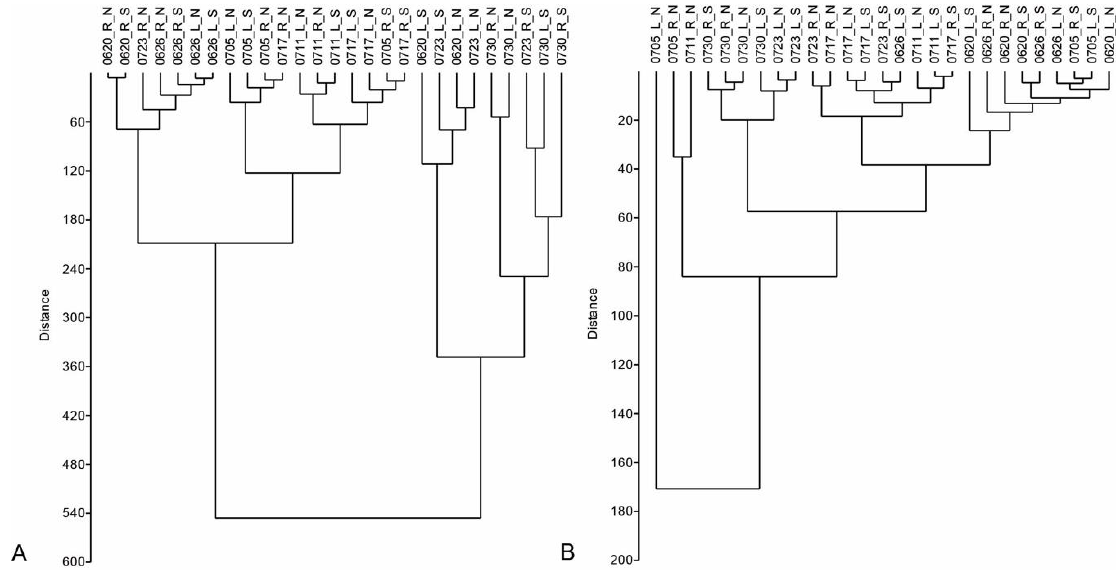
Figure 2. Euclidean distance-based cluster analysis (using Ward’s method) of general physical-chemical variables ( A ) and element concentrations ( B ).